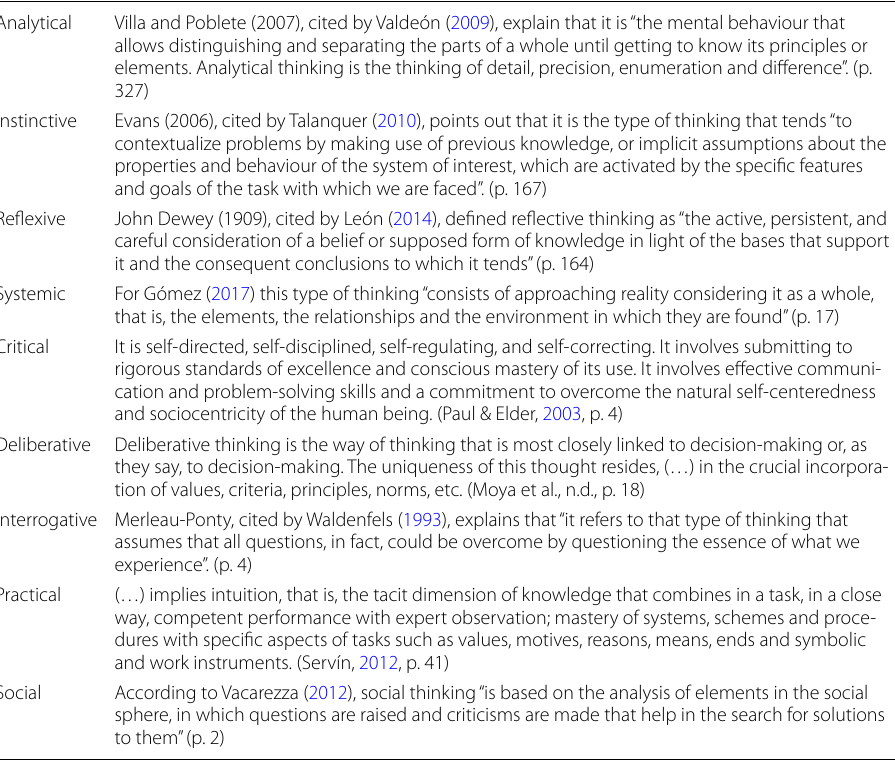
Table 3 Other types of thinking. Multiple sources. Elaborated by Félix Socorro. May 2020